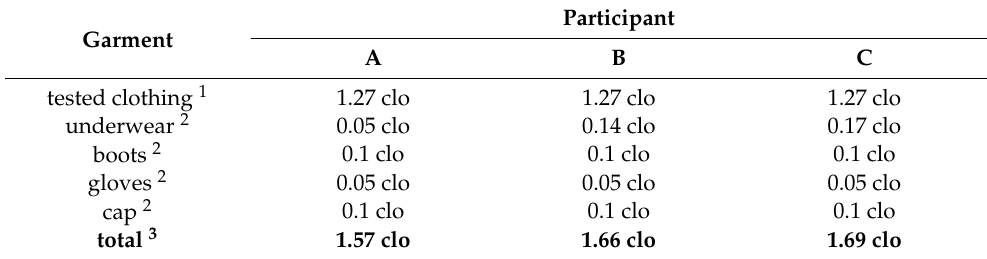
Table 2. Thermal insulation of garments.